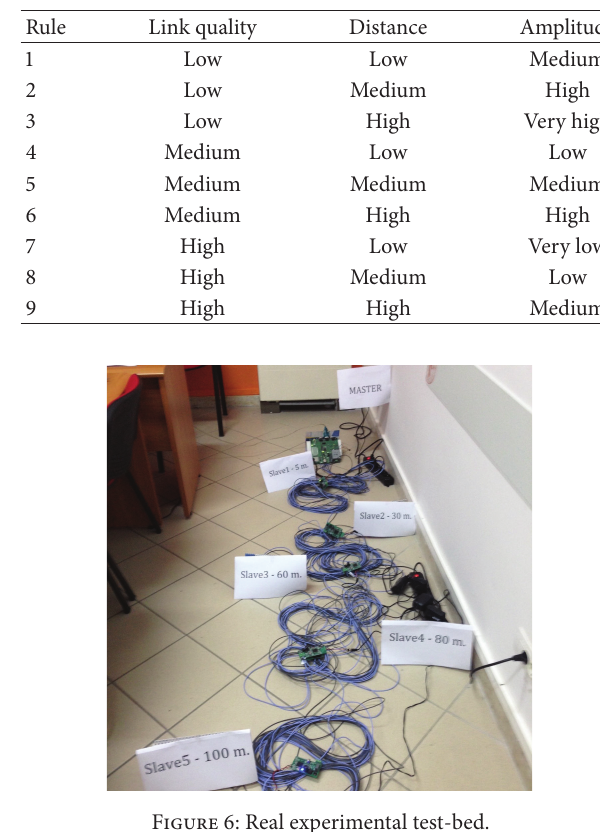
Table 2: Fuzzy rules.